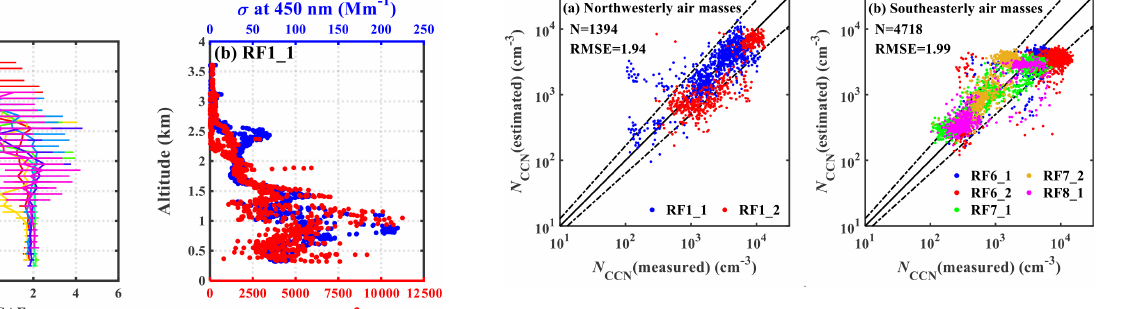
Figure 7. Comparisons between measured N CCN at 0.7%SS and estimated N CCN at 0.7%SS using Eqs. (4) and (5) for different vertical spiral flights in (a) northwesterly and (b) southeasterly air masses. The black solid lines are 1 : 1 lines and the dashed lines indicate the boundaries representing ± 10% deviations of N CCN (estimated) from N CCN (measured) in the log–log plot. The 10% deviation means that the deviation of individual data points is typi- cally within a factor of 1.26 of the best estimates. The point number ( N ) and root mean square error (RMSE) in each panel are